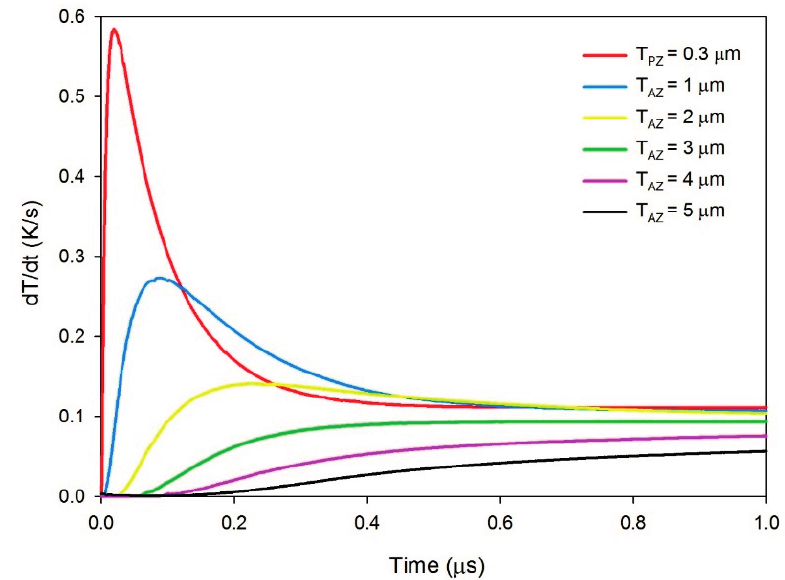
Figure 11. Relationship between the temperature variation rate and time at points PZ 5 and AZ 5 in the multi-frequency band pyroelectric sensor under sputtered ZnO film with a constant thickness of 0.3 μ m and aerosol ZnO film with various thicknesses from 1 to 5 μ